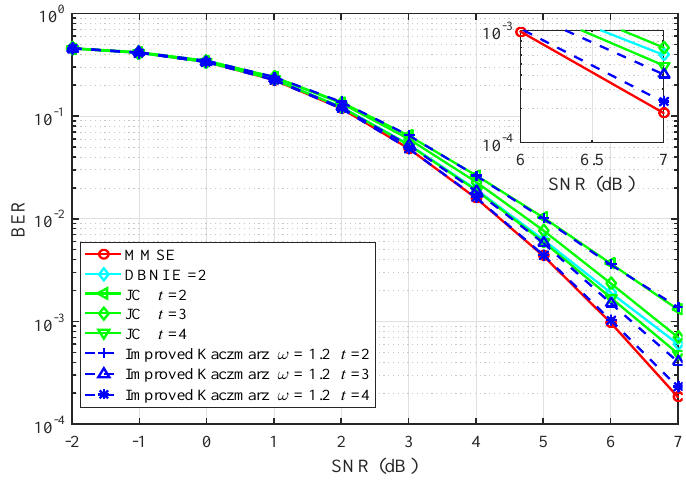
Figure 3. BER performance comparison (64 ×